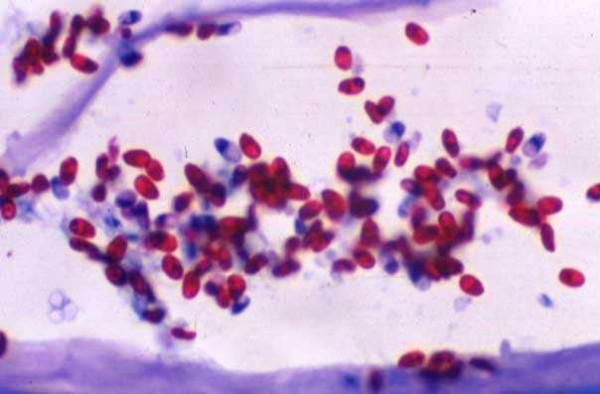
Section of corneal button in which the spores appear red with darkly stained band at the tip (1% acid-fast stain, ×1000).